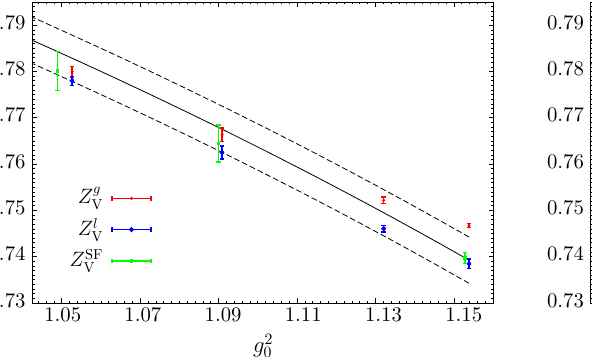
< 1, here not 0 → 0 0